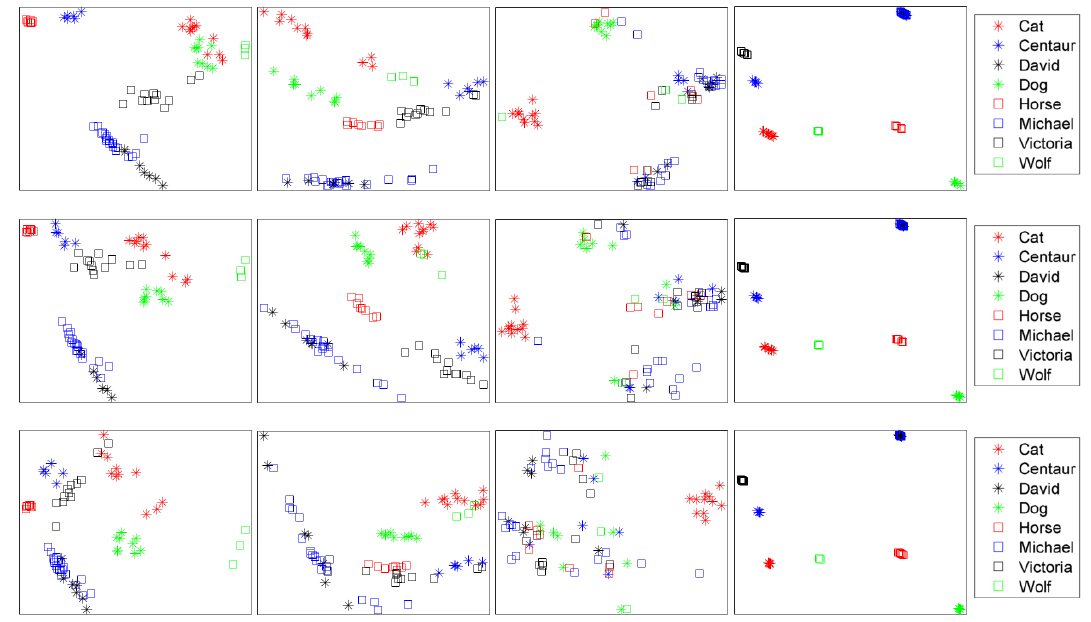
Figure 7. 2D PCA projection of shape descriptors computed by (from left to right) Shape-DNA, cShape-DNA, GPS, and LESI algorithms from perturbed TOSCA dataset with (from top to bottom) 0.5%, 1%, and 2% noise level,